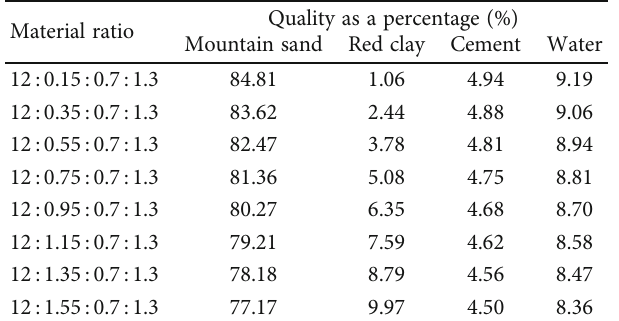
Table 2: Quality proportion of similar materials in di ff erent